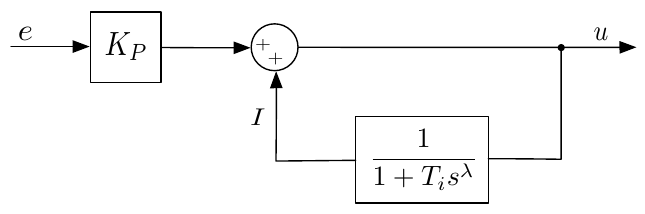
Figure 4. Fractional proportional-integral (PI) controller scheme (classical implementation with automatic reset).